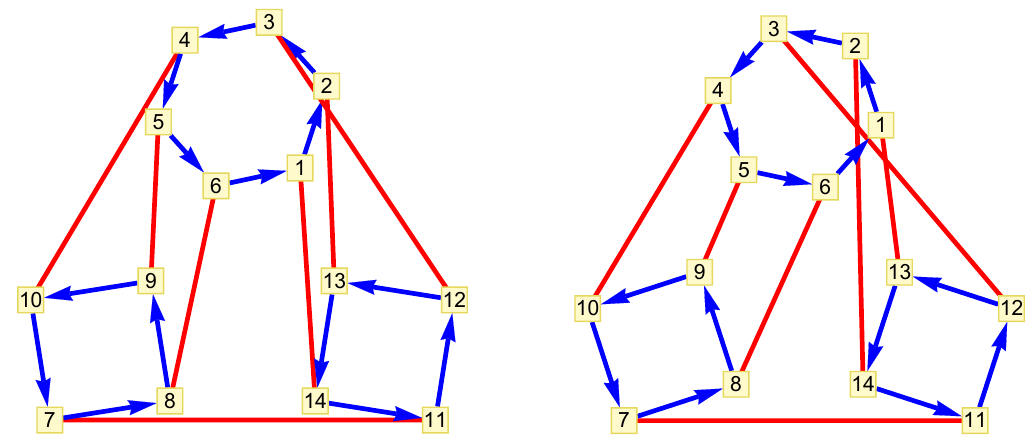
Figure 1 . The Cayley graphs generated by ( (cid:11); W ) for hO 1 O 2 O 3 i with ( L 1 ; L 2 ; L 3 ) = (6 ; 4 ; 4). The left (cid:12)gure corresponds to a planar term, and the right (cid:12)gure to a non-planar